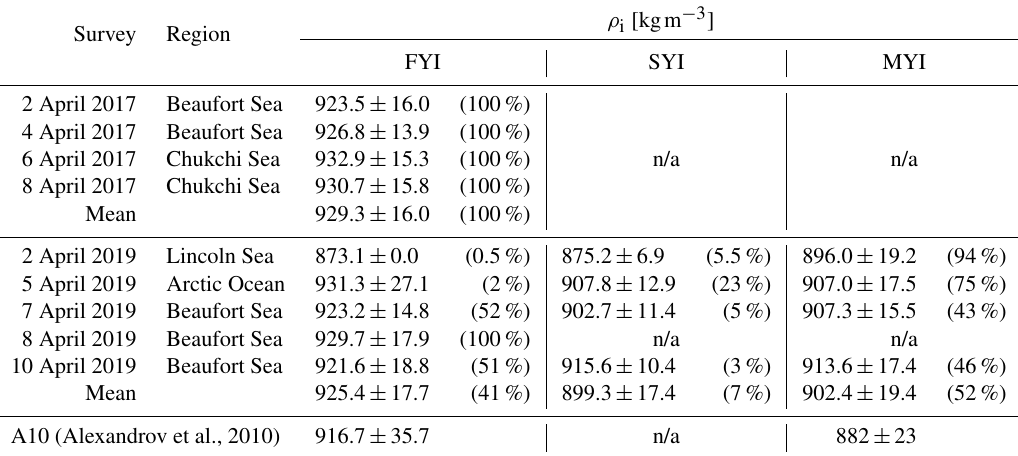
Table 3. Summary of the 800m along-track averaged sea-ice bulk density (inverse-uncertainty weighted mean ± 1 standard deviation) according to survey and ice type. The mean values correspond to the red crosses in Fig. 6. The percentage of each sea-ice type encountered on each survey is given in parentheses.